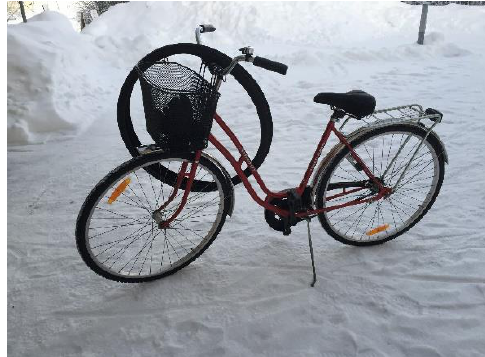
Figure 3. “This is a picture of my bike the first day I got new tires; I remember that my parents were quite anxious, but then they tried the bike and got much more positive. I think that now after the project that they do not even think about me biking to school, it is nothing more special than doing it in the summertime” Sofia C26.